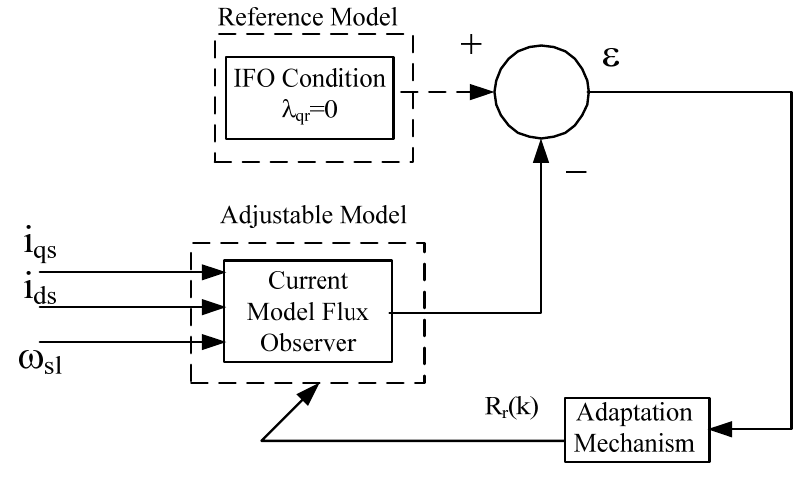
Figure 13. MRAS structure for rotor resistance adaptation.